Question: Describe this figure in one sentence.
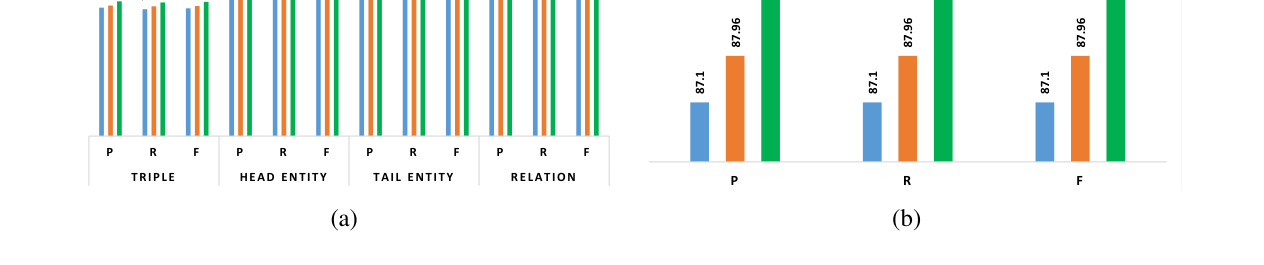
Answer: (a): Precision (P), Recall (R), F1 results with different chunk length m settings in the task of biomedical triple extraction task. (b): Precision (P), Recall (R), F1 results with different chunk length m settings in the task of biomedical relation extraction task.